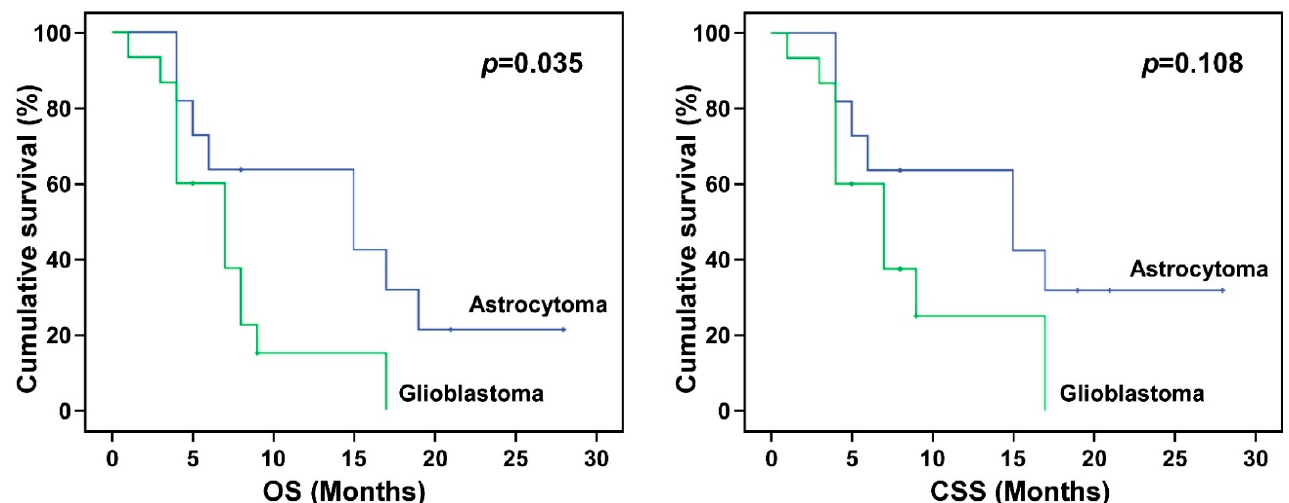
Figure 1. Kaplan–Meier curves for different tumor types. Kaplan–Meier survival curves for overall survival (OS) and cancer-specific survival (CSS) of patients with astrocytoma and glioblastoma. BNCT treatment showed a better OS in patients with astrocytoma than in those with glioblastoma.